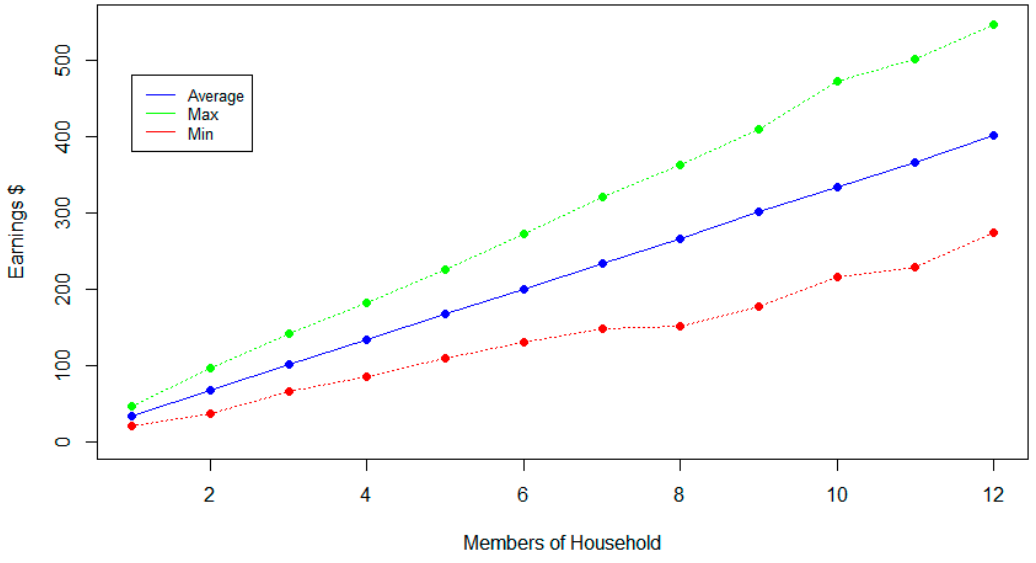
Figure 6. Average monetary gain with minimum and maximum per size.